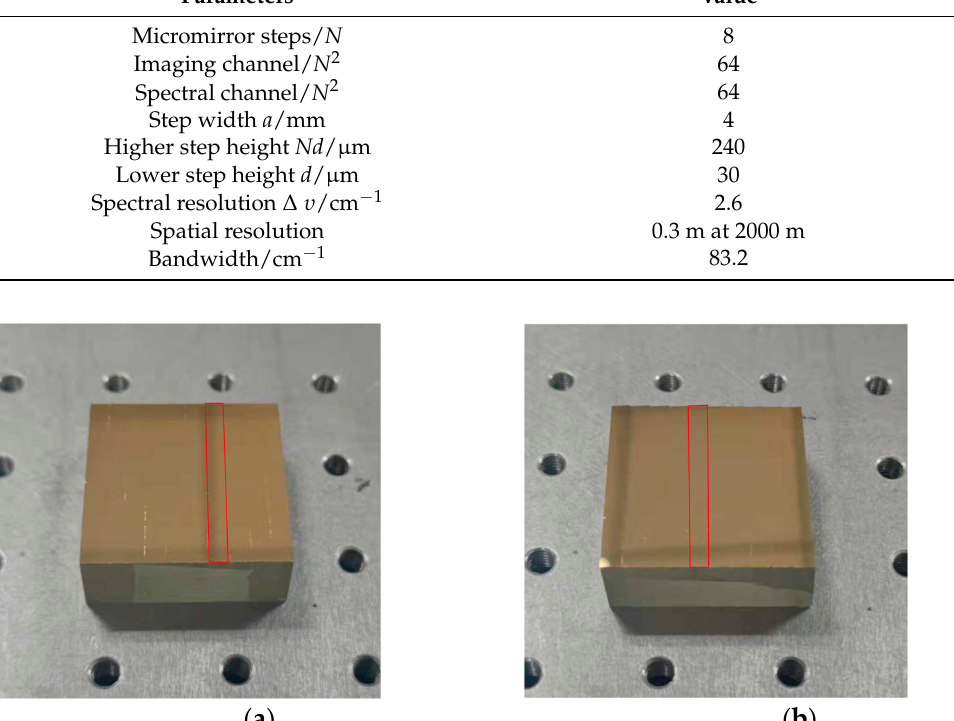
Figure 2. Pictures of the stepped micromirrors; the red border indicates the direction of the steps: ( a ) the higher stepped micromirror has a step height of 240 μ m; ( b ) the lower stepped micromirror with a step height of 30 μ